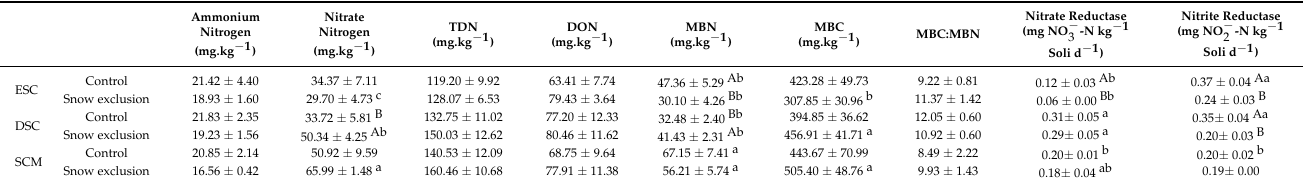
Table 1. Effect of snow exclusion on soil N pools, microbial biomass, and enzyme